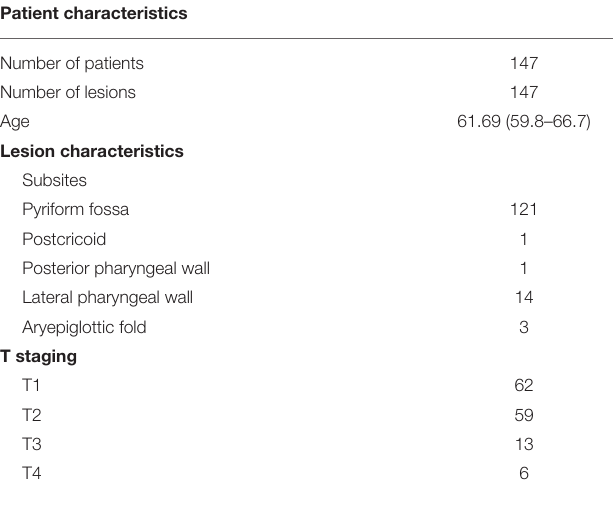
TABLE 3 | Patient and lesion characteristics of TORS.